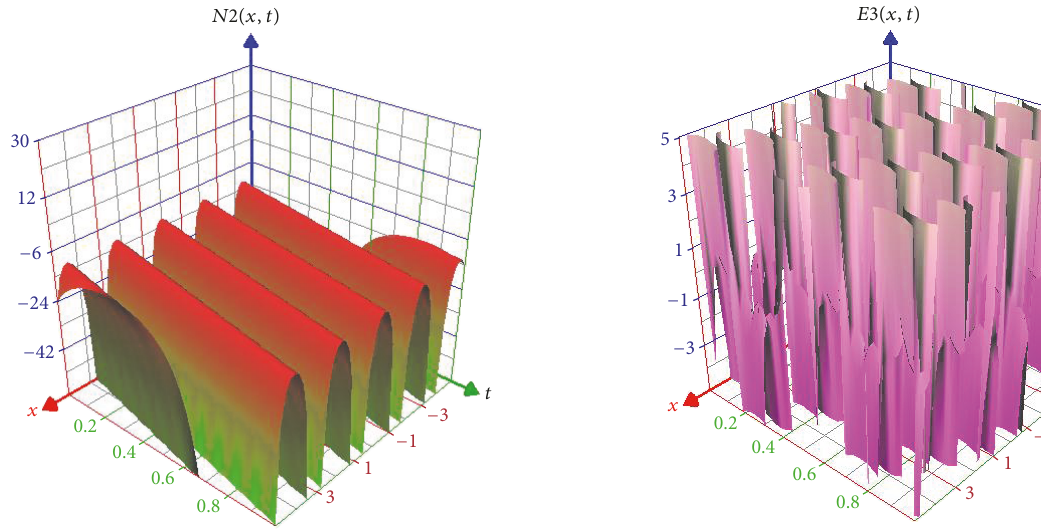
Figure 5: The solitary wave of the real part of 𝐸 3 (𝑥,𝑡) in (40) for −5 ≤ 𝑥 ≤ 5 , 0 ≤ 𝑡 ≤ 1